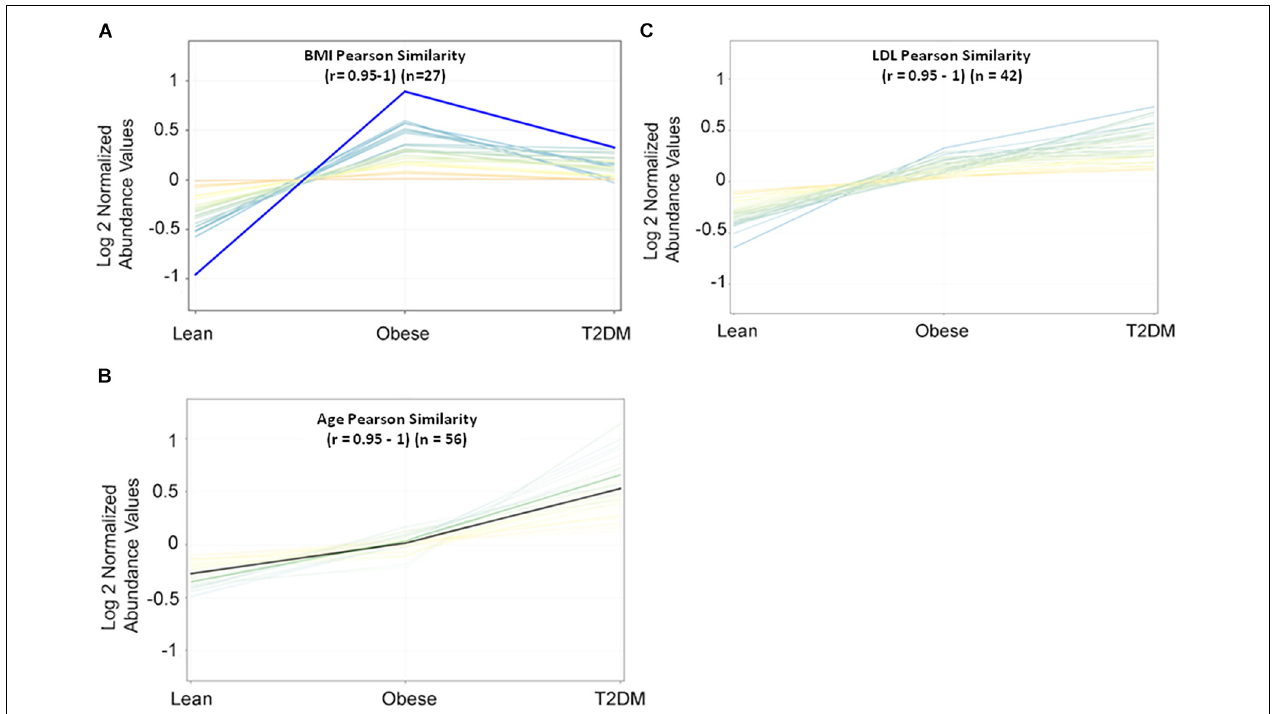
FIGURE 1 | Pearson similarity tests ( r = 0.95–1) were filtered out with 27, 56, and 42 metabolites as (A) BMI-dependent; (B) age-dependent, and (C) LDL-C-dependent, respectively.